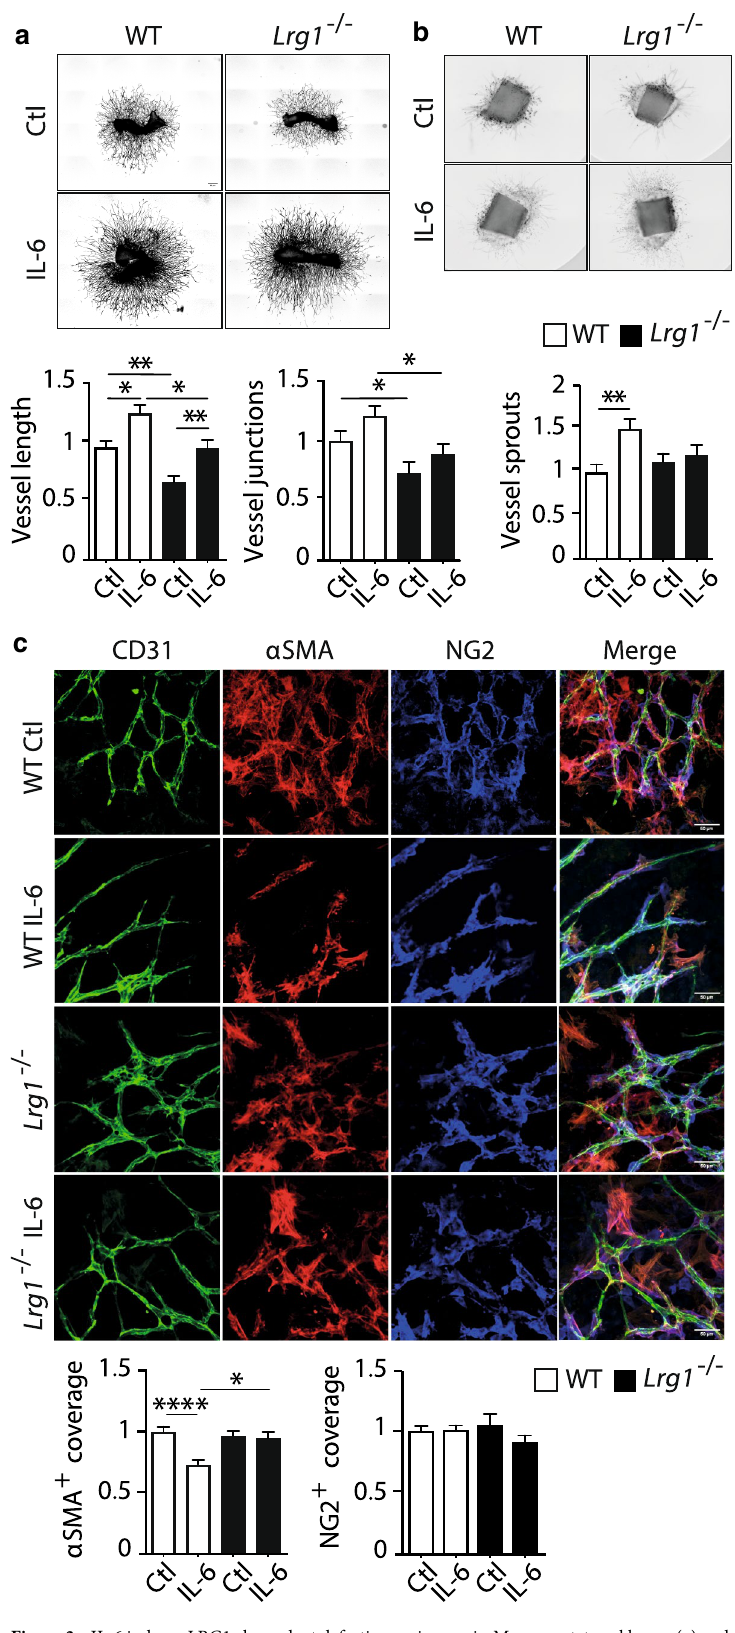
Figure 3. IL-6 induces LRG1-dependent defective angiogenesis. Mouse metatarsal bones ( a ) and aortic rings ( b ) from wild type C57Bl6 and Lrg1 −/− mice were cultured and treated with 50 ng/ml IL-6 and analysed for angiogenesis and sprouting respectively. ( c ) Representative images of metatarsal bones treated with PBS as control (Ctl) or 50 ng/ml IL-6 and stained with antibodies against CD31 (green), NG2 (blue), and αSMA (red) for mural cell coverage and analysis. Scale bars, 50μm. N ≥ 3 independent experiments. ANOVA with multiple comparisons test ( a – c : Dunn’s, b : Tukey’s), Mean ± SEM, * ≤ 0.05, ** ≤ 0.01, **** ≤